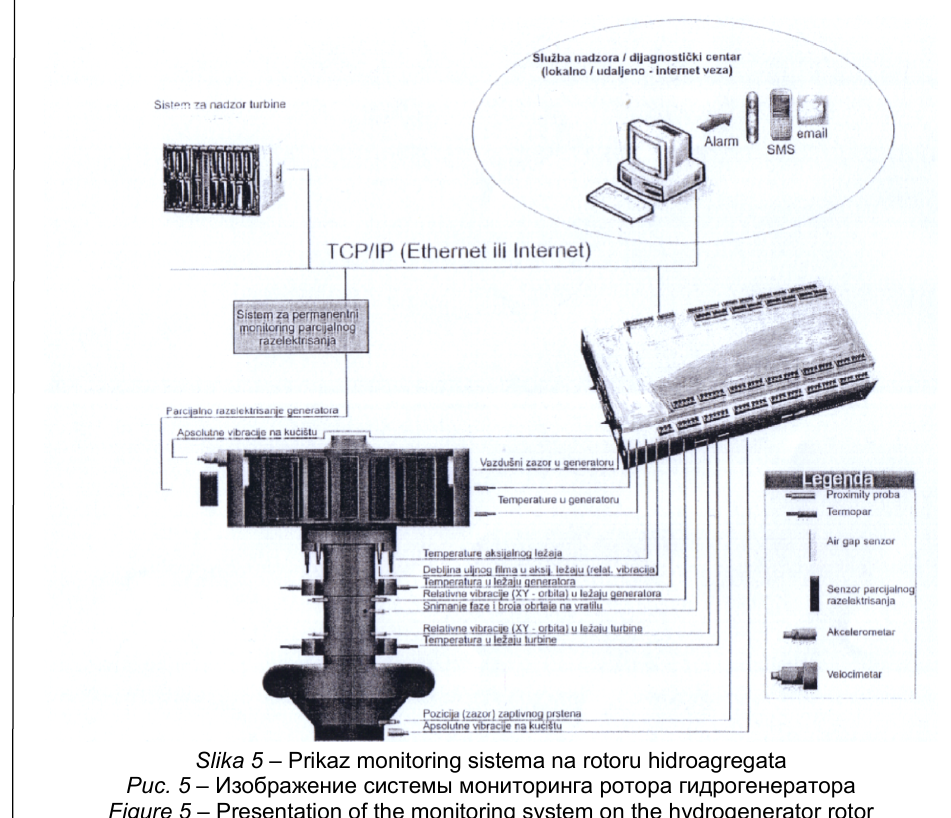
Figure 5 – Presentation of the monitoring system on the hydrogenerator